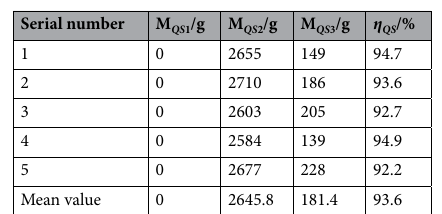
Table 5. Quality distribution of crushed straw in different areas.